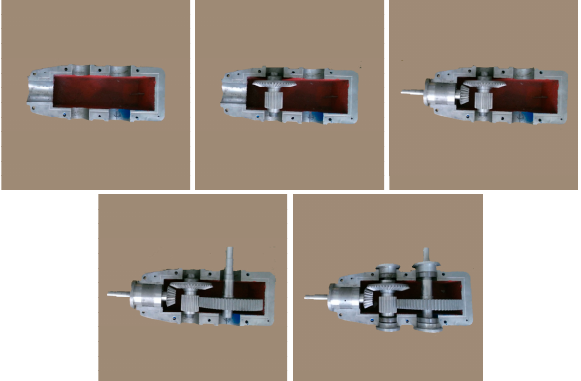
Figure 6. Actual assembly RGB dataset.